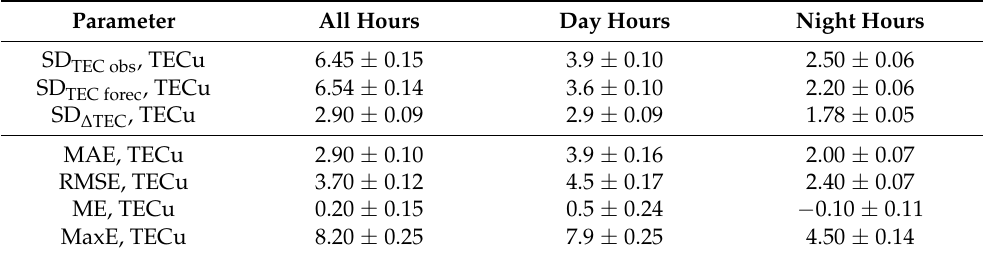
Table 4. The standard deviations of the observed and forecasted TEC, and the standard deviation of ∆ TEC and the mean errors for the PCA-MRM (L31, mean.lag1.2) model: all hours, day hours and night hours.